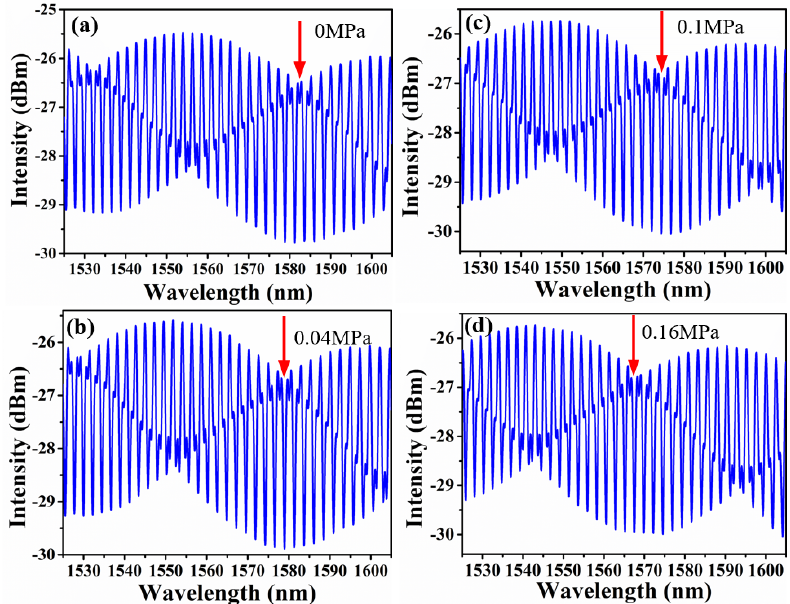
Figure 6. Output reflective spectra of sensor 4 with the relative pressure varying from 0 to 0.16 MPa: ( a ) 0 MPa; ( b ) 0.04 MPa; ( c ) 0.1 MPa; ( d ) 0.16 MPa.